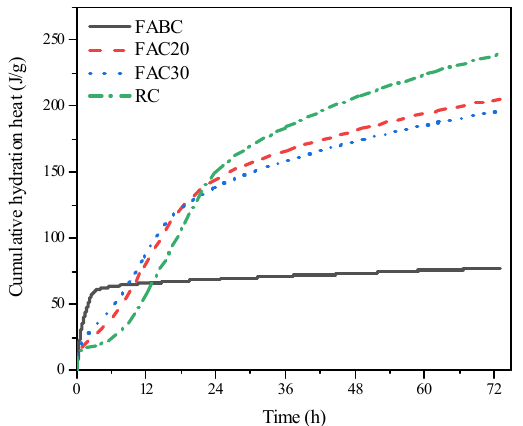
Figure 2. Hydration heat of cement with different FABC content.